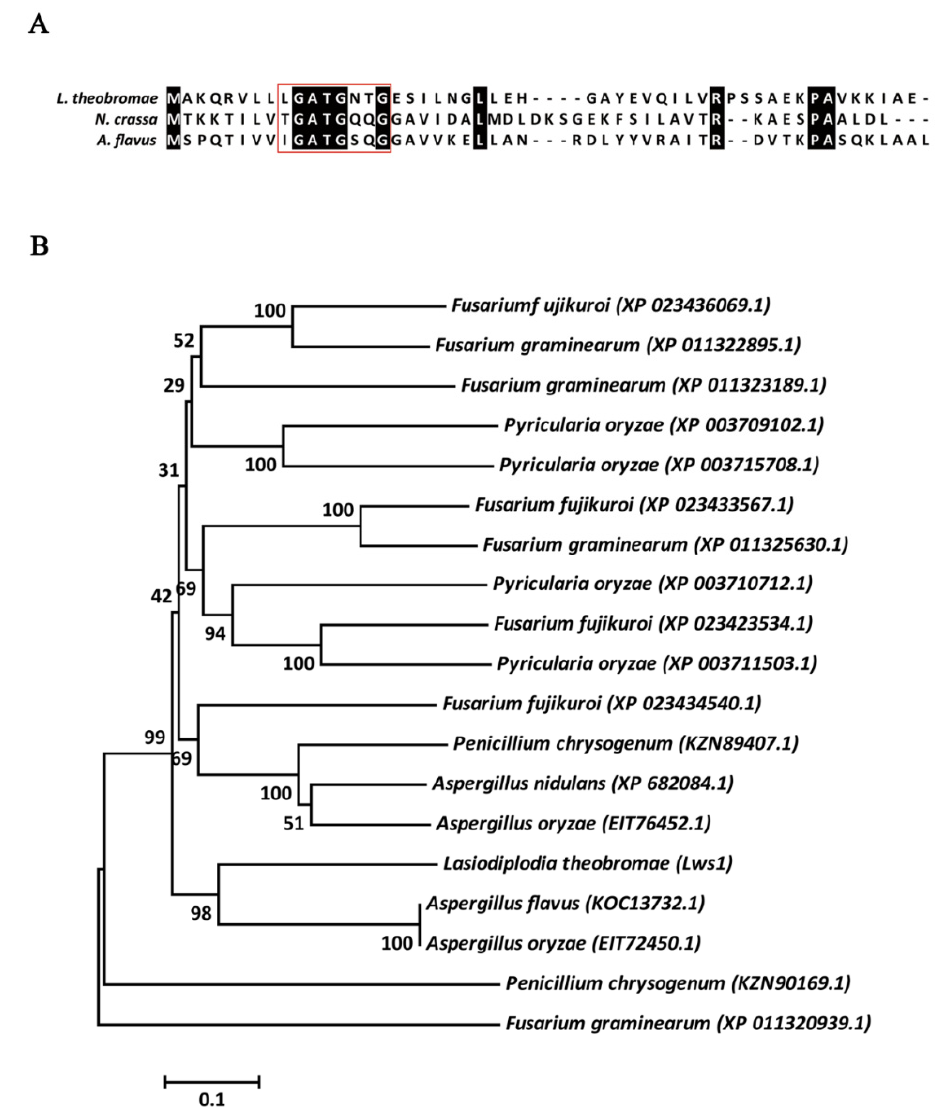
Figure 1. Structural and phylogenetic analyses of NmrA homologs in L. theobromae and other filamentous fungi. ( A ) Multiple sequence alignments of NmrA homologs (N-terminal amino acid residues 1–50) from L. theobromae , N. crassa , and A. flavus . Amino acid sequences were aligned using the ClustalX2 program and then edited with Jalview software. The same amino acids are highlighted in black. Residues boxed in red denote the conserved glycine-rich motif of the Rossmann fold. ( B ) Phylogenetic analyses of NmrA homologs from various fungal species. The phylogenetic tree was generated using amino acids sourced from the NCBI database via MEGA7 with the neighbor-joining method, with 2000 replicates. Bootstrap percentage support for each branch is marked at the